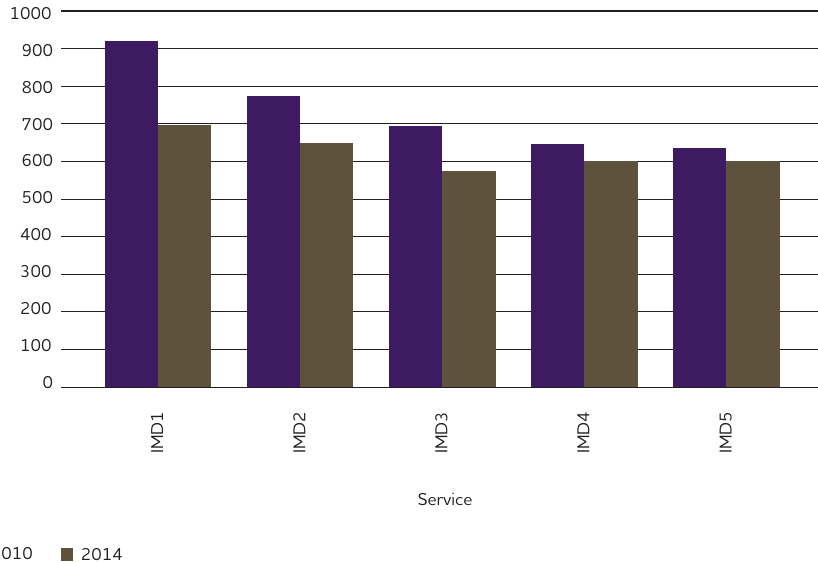
Figure 7: Per Capita Expenditure Profile by deprivation bands for English All-Purpose Authorities, 2010/11 and